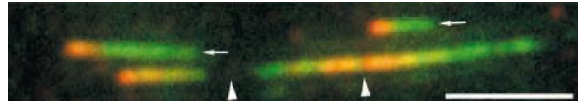
Figure 2. Labeling patterns of newly replicated DNA visualized on DNA fibers. DNA was first labeled with CldU for 10 min (green) and then with IdU for 5 min (red). Two isolated elongating forks (arrow) and replicons with initiation and termination sites (arrowheads) are shown. Bar = 5 µm. Adapted with permission from Malínský et al., 2001, The supply of exogenous deoxyribonucleotides accelerates the speed of the replication fork in the early S phase. Journal of Cell Sciences 114, 747–750 [54].